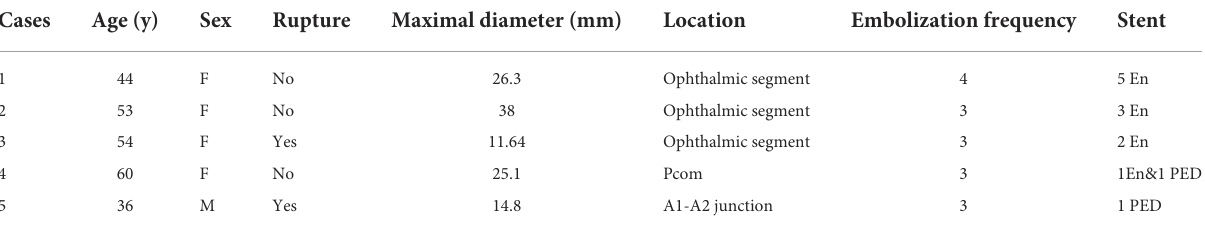
TABLE 5 Baseline data of recurrent refractory aneurysms.